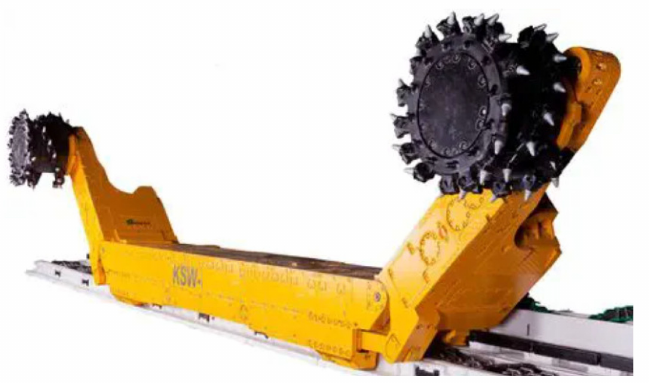
Figure 1. KSW-460NE shearer machine.